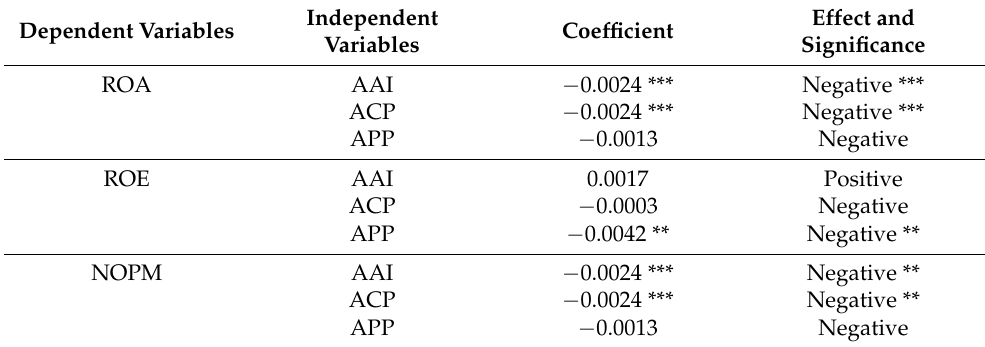
Table 6. Summary of the key